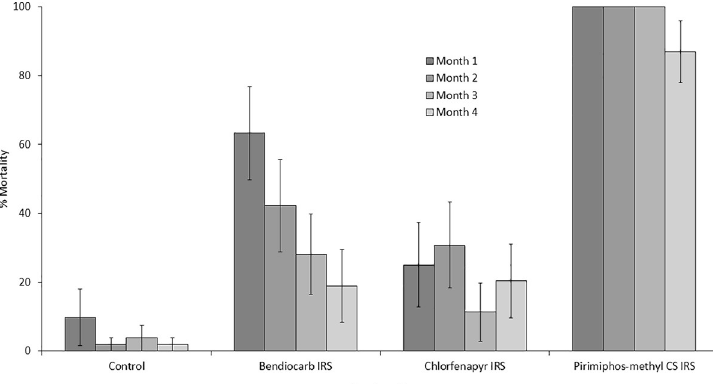
Fig 4. Mortality (72 h) of laboratory maintained, insecticide-susceptible Anopheles gambiae sensu stricto Kisumu colony exposed to IRS-treated hut walls in monthly, 30 mins wall cone bioassays in experimental huts in Cov è , southern Benin. Error bars represent 95% CI. Approximately fifty (50) 2–3 days old mosquitoes were exposed for 30 mins to each IRS treated hut in batches of 10 per cone and mortality recorded after 72 h.